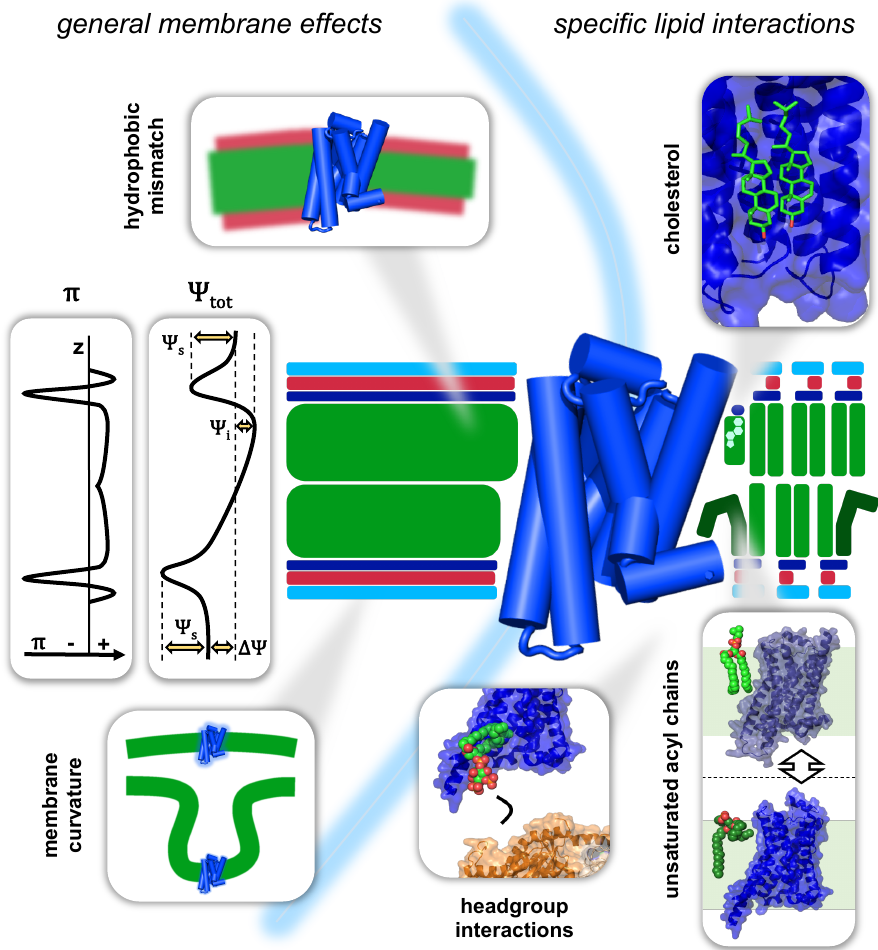
Figure 2. Schematic overview of important interactions of GPCRs with their membrane environment. On the left, general membrane effects are depicted. π : common lateral pressure profile in the z dimension of a lipid bilayer. While the lateral pressure is generally positive in the hydrocarbon core, it is inversed to strong tensions in the carbonyl region. Ψ tot : electric potential across a cellular membrane. The graph depicts the sum of the individual potentials ∆Ψ (transmembrane potential), Ψ s (surface potential of the lipid headgroups) and Ψ i (potential in the core of the membrane). The cartoon is inspired by Honig (1986) [30]. Membrane curvature: the curvature of membranes can range from near zero to strong membrane-invaginations and highly curved vesicular membranes. Hydrophobic mismatch: the difference in hydrophobic thickness between a lipid bilayer and the TMDs of a GPCR can strongly affect the structure and dynamics of the latter. On the right, examples of specific lipid–GPCR interactions are illustrated. Cholesterol: one important stoichiometric interaction partner of many GPCRs is cholesterol. The figure shows the crystal structure of the human β 2 adrenergic receptor (blue) in complex with cholesterol molecules (green) (PDB accession code: 2RH1). Headgroup interactions: in the interface region of a membrane, GPCRs interact with lipid headgroups. Several of these interactions have been shown to occur in a lipid-specific and stoichiometric way. The figure shows a model of a PIP2 molecule (green), forming a ternary complex with a GPCR (blue) and a heterotrimeric G protein (orange). The figure was based on findings by Yen et al., 2018 [31] and was designed with crystal structures of the β 2 adrenergic receptor and a heterotrimeric G protein (PDB accession codes: 3SN6, 6EG8).